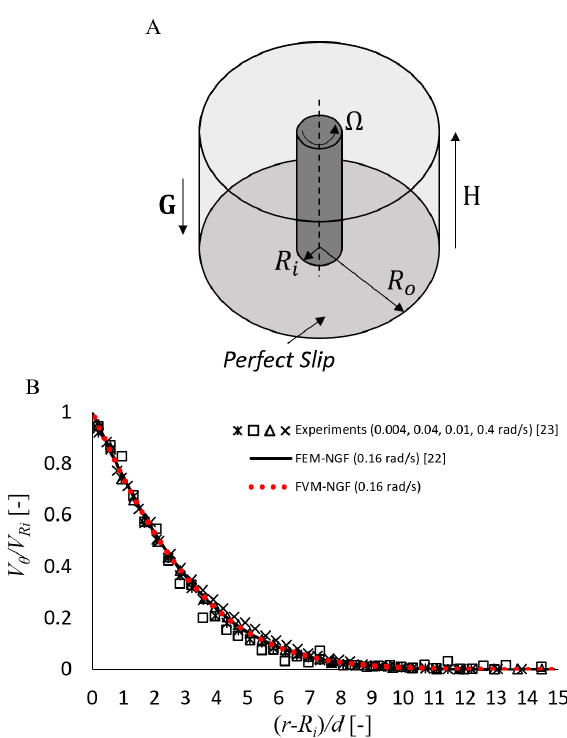
Figure 2. (A) Annular shear cell schematic and (B) surface ve- locity profile comparison between experiments (symbols), FEM implementation (black solid line) and our FVM implementation in which the viscosity model is given by Eq. (1) and (12) (red dotted